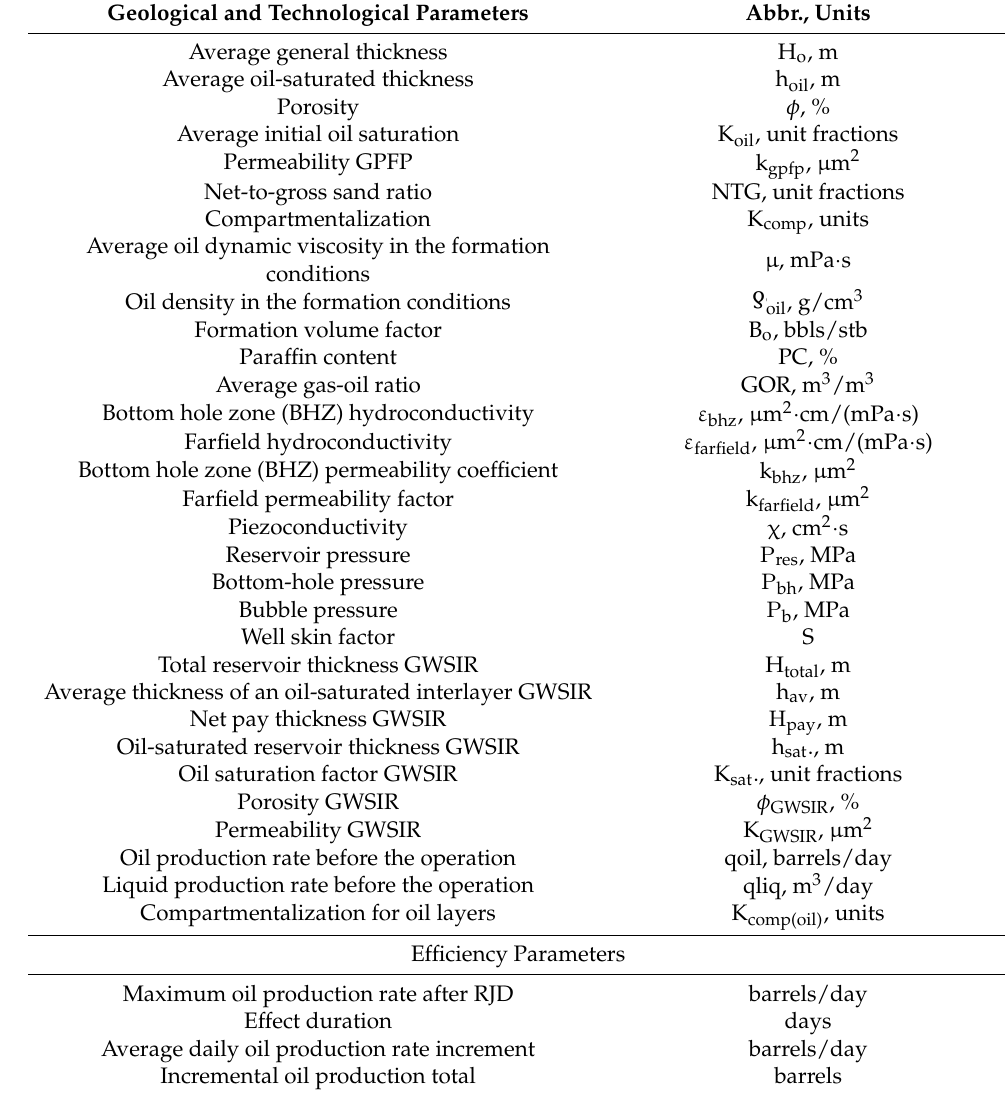
Table 1. Investigated parameters.